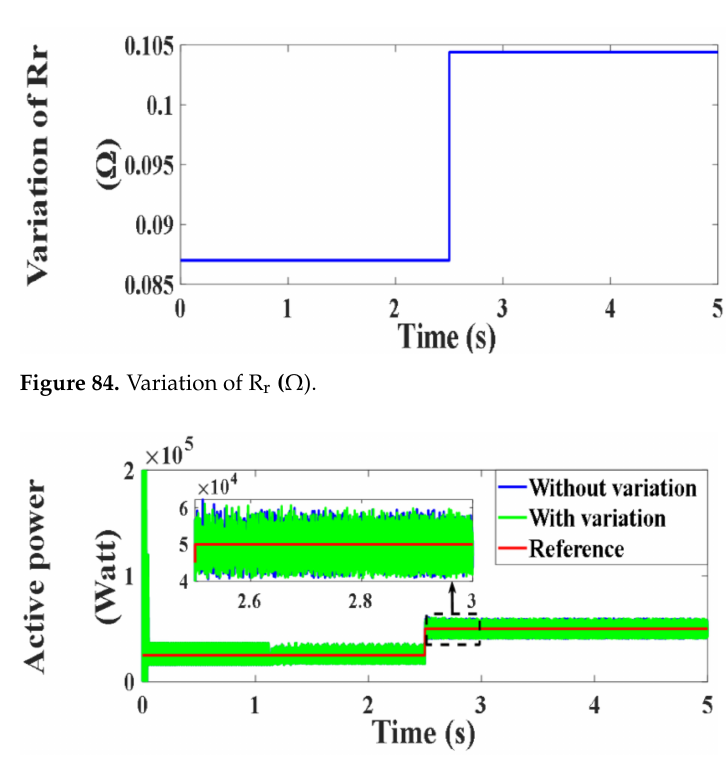
Figure 85. Active power under PVC